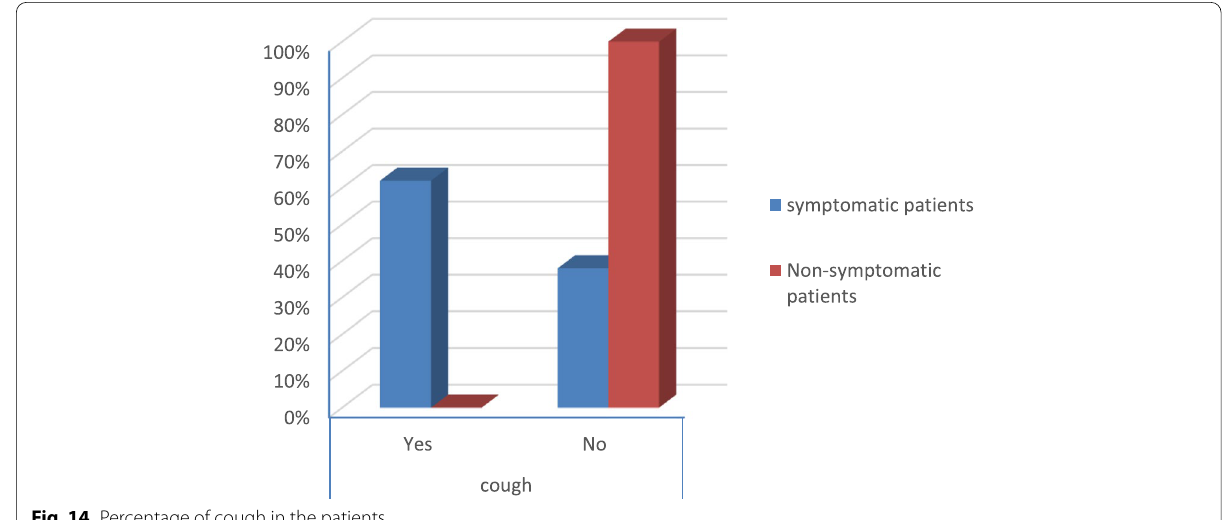
Fig. 14 Percentage of cough in the patients